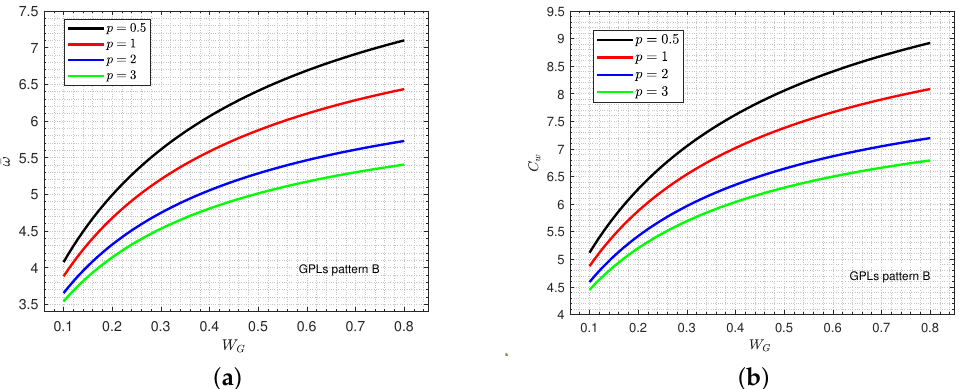
Figure 5. ( a ) Wave frequency ¯ ω (THz) and ( b ) phase velocity C w (km/s) of the FG GPLs-reinforced sandwich nanocomposite piezoelectromagnetic plate with a honeycomb core versus the graphene weight fraction W G for various values of the power law index p (GPLs pattern B).